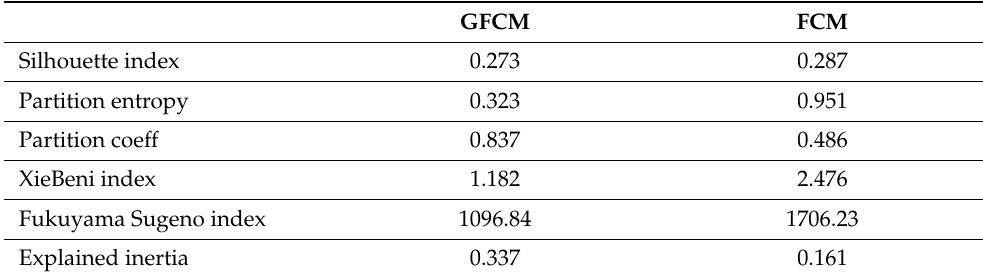
Table 4. Comparison of the indices between GFCM and FCM.